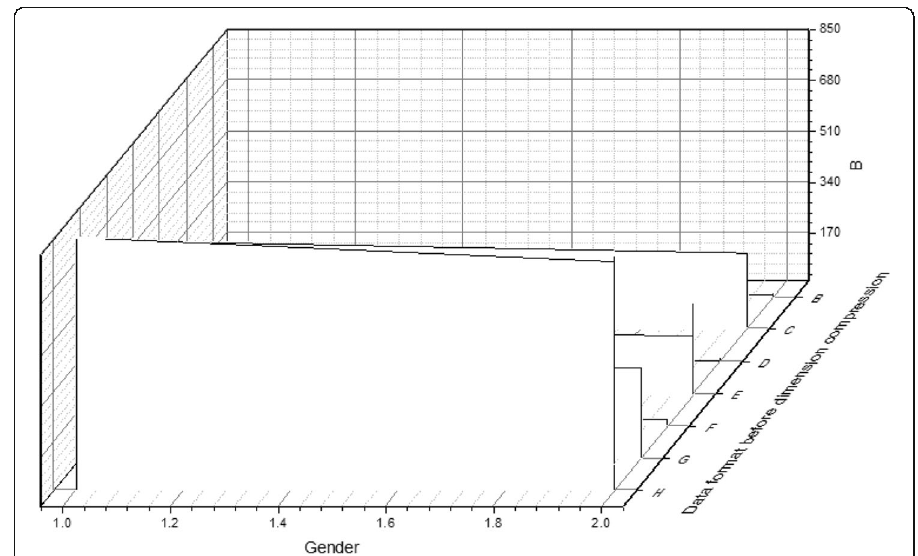
Fig. 3 Data model diagram